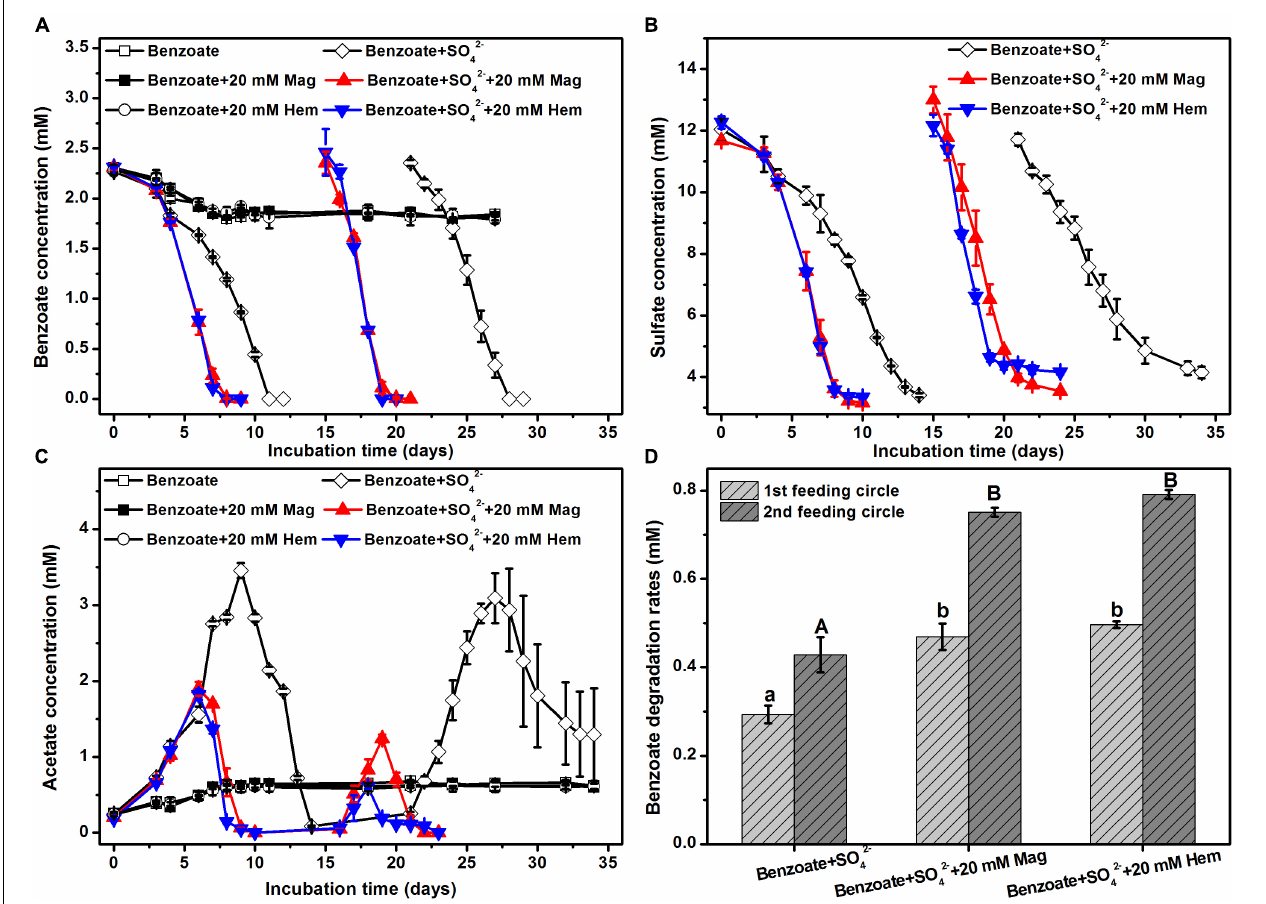
FIGURE 1 | Sulfate-dependent benzoate degradation in the anaerobic incubation of sediments from Pearl River Estuary in the presence and absence of conductive iron oxides: (A) benzoate degradation; (B) sulfate reduction; (C) acetate concentration; (D) benzoate degradation rates (calculated from the phase with fastest benzoate degradation). Two feeding cycles were included. The lowercases and capitals letters indicate the significant differences among three treatments in the first and the second feeding cycle, respectively. Mag and Hem denote magnetite and hematite, respectively.